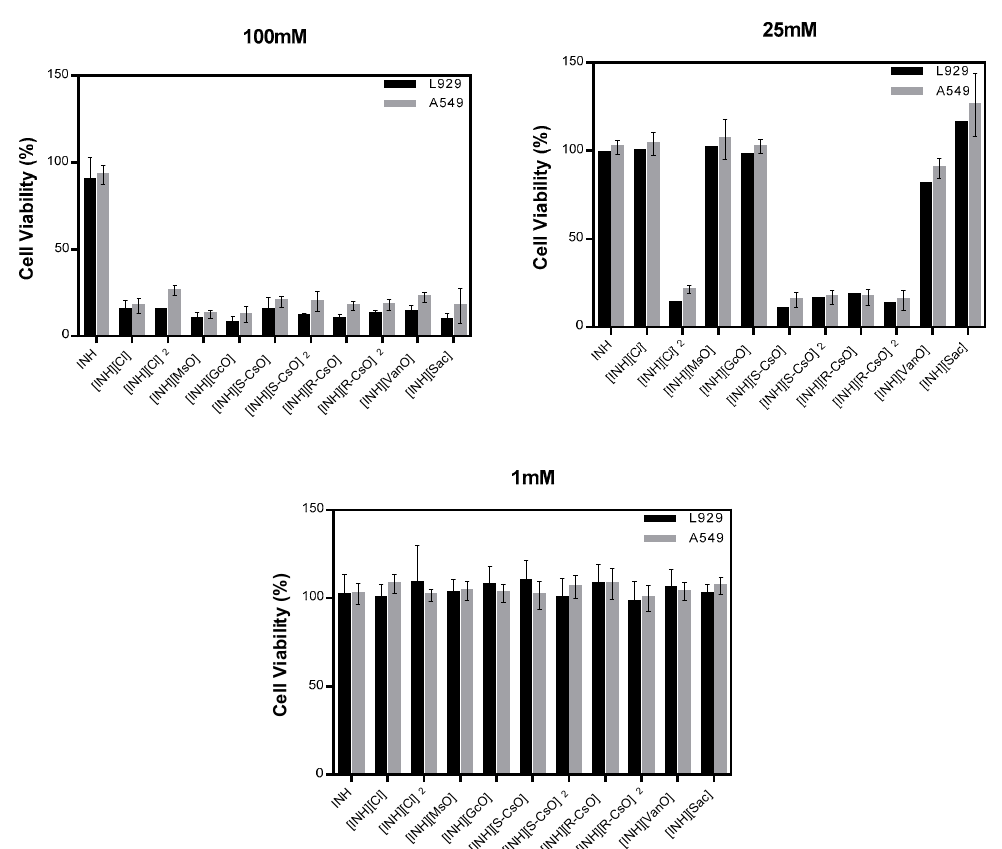
Figure 3. Cell viability of isoniazid and organic salts with isoniazid in L929 and A549 cell lines, in different concentrations.